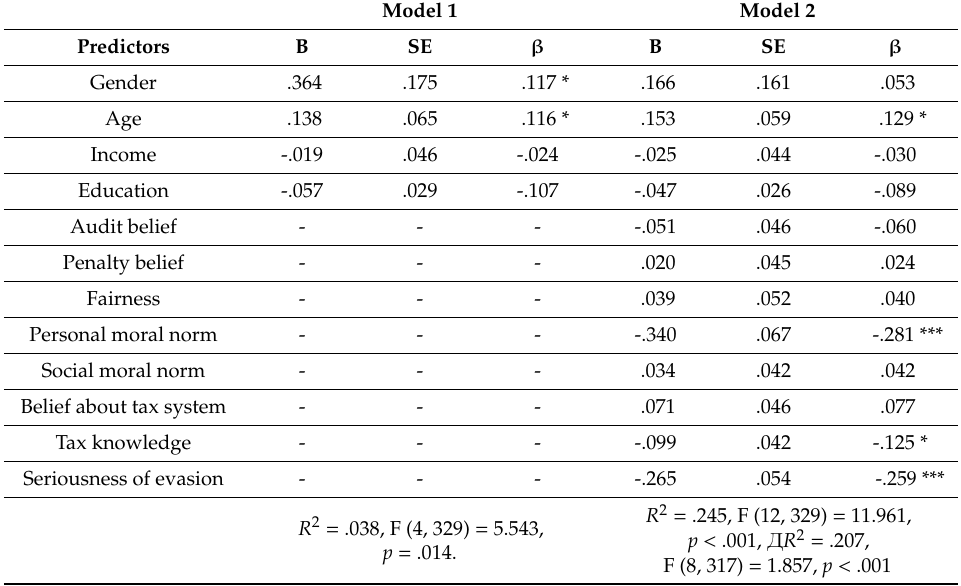
Table 3. Regression analyses for tax